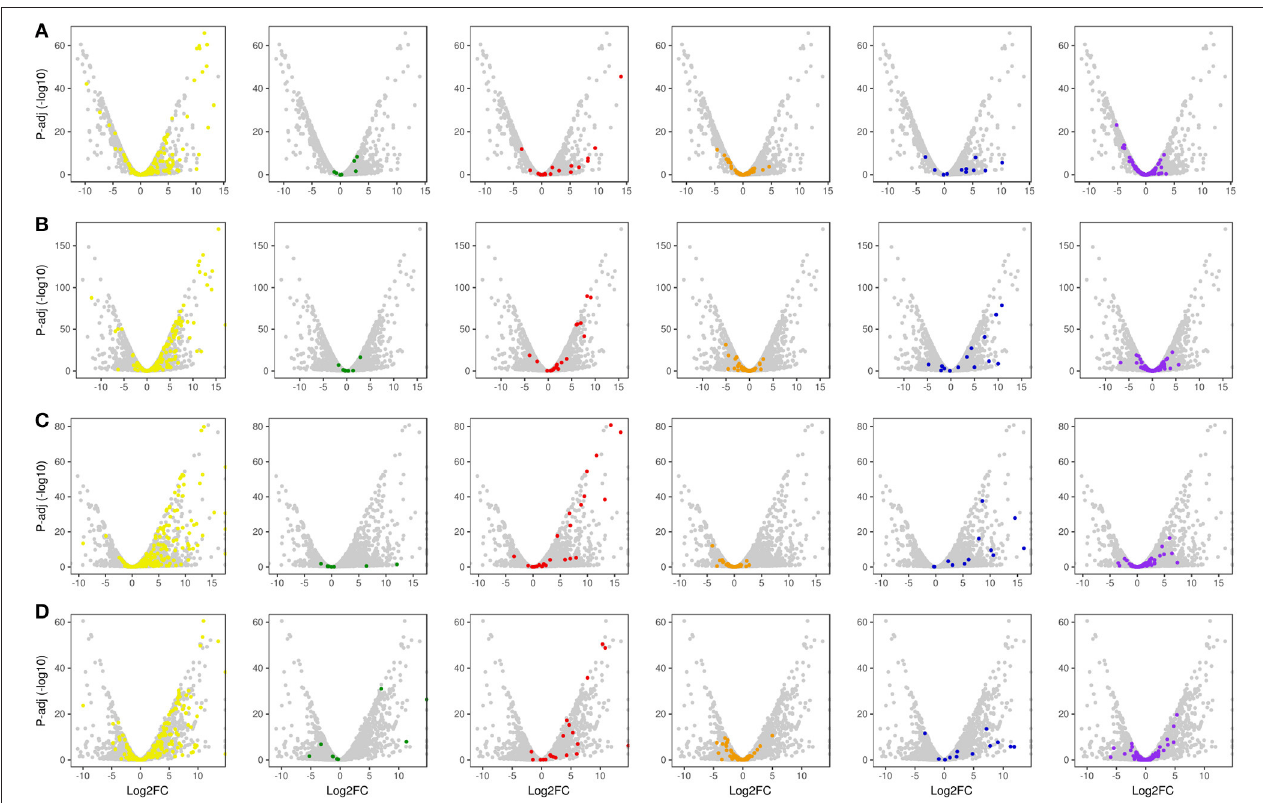
FIGURE 5 | Global volcano scatter plot analysis of expression modulation of CAZyme-encoding genes, transcription factors and un-annotated genes. (A) LB36 vs. LG36; (B) LB48 vs. LG48; (C) SB36 vs. SG36; (D) SB48 vs. SG48. Yellow dots, GH family CAZyme-encoding genes; Green dots, CMB family CAZyme-encoding genes; Red dots, CE family CAZyme-encoding genes; Orange dots, GT family CAZyme-encoding genes; Blue dots, PL family CAZyme-encoding genes; Purple dots, Transcription Factor-encoding genes; Gray dots, un-annotated genes.